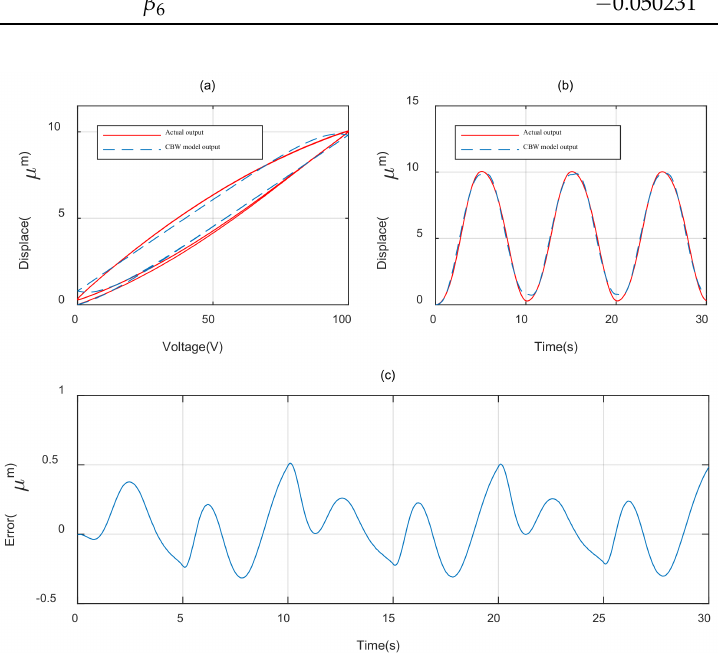
Figure 7. Modeling result of CBW model. ( a ) Hysteresis loop. ( b ) Displacement curve. ( c ) Error curve.